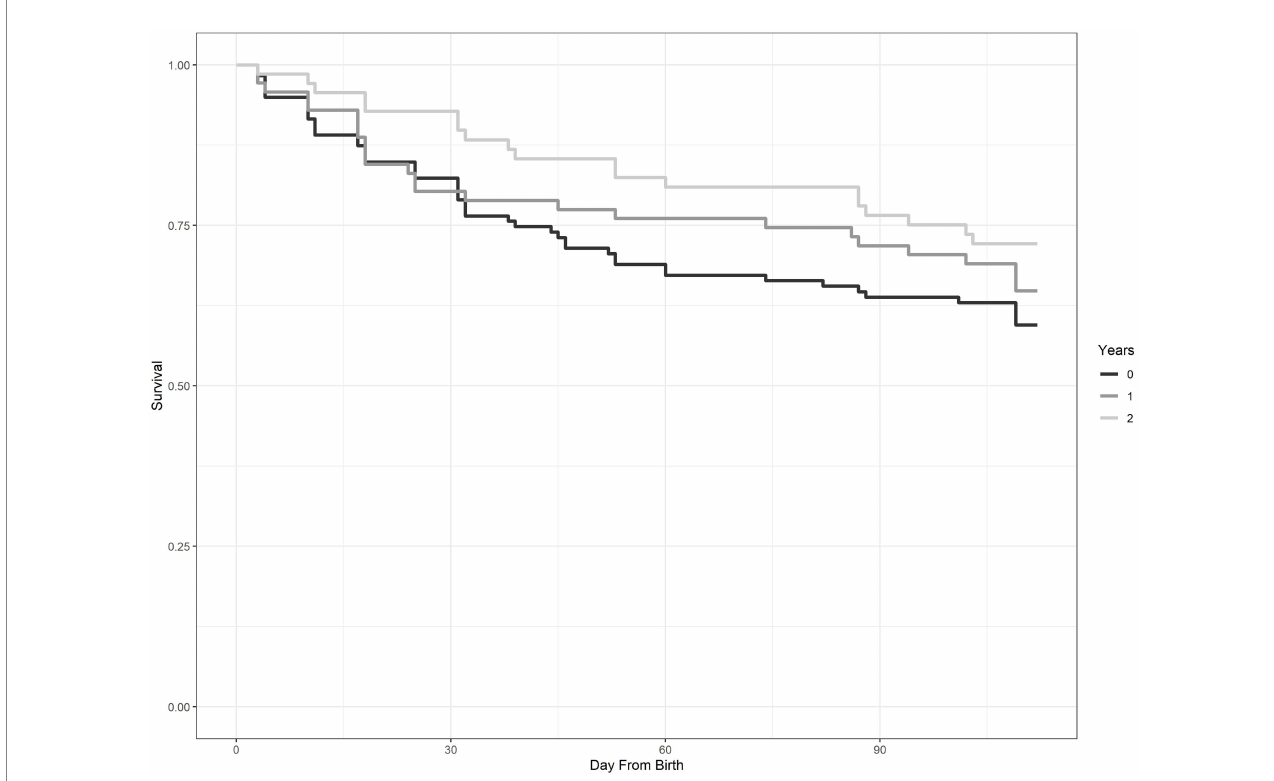
FIGURE 2 Survival curves for neonate mule deer produced using a Kaplan–Meier function. The three curves illustrate survival of fawns with no removal of coyotes (0), 1 year of removal of coyotes (1), and 2 years of removal of coyotes (2). This study was conducted on Monroe Mountain, Utah, United States during 2012– 2015.